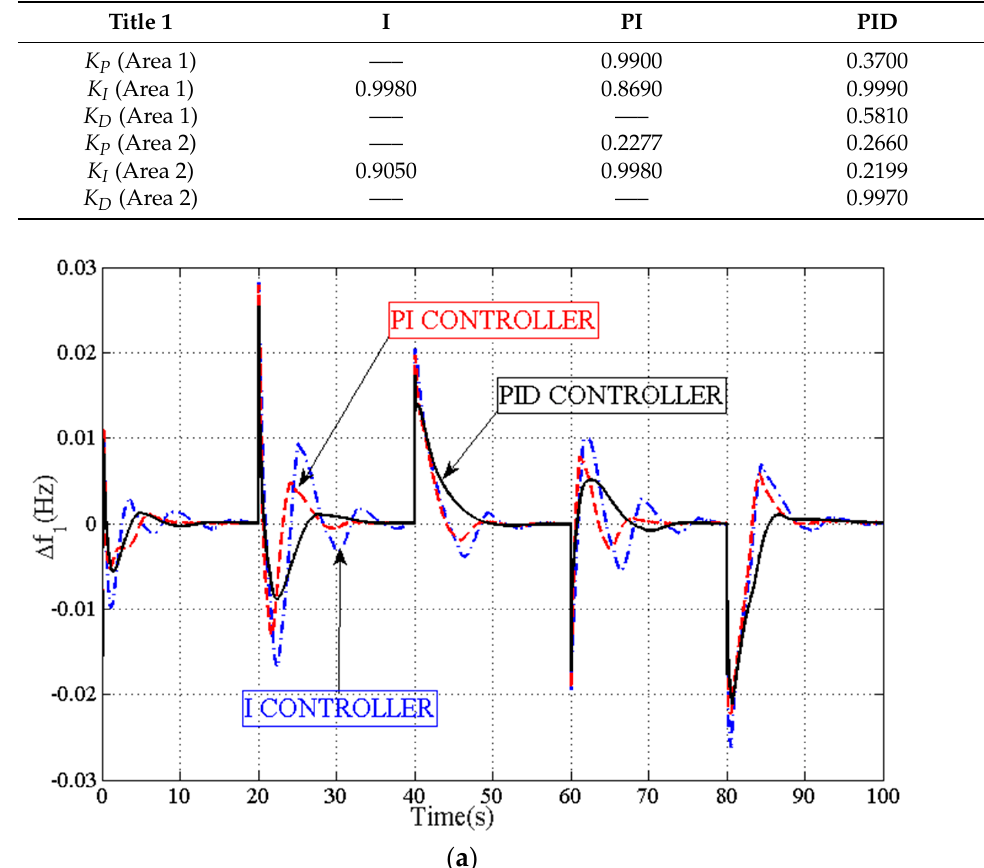
Figure 11. The randomized-nature disturbance. Table 3. The SAO-I, SAO-PI, and SAO-PID parameters with RND.